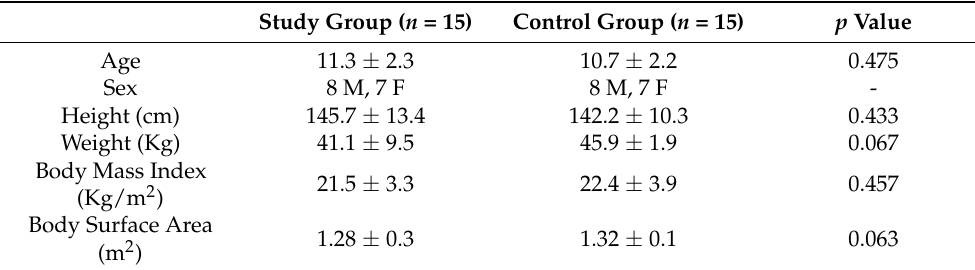
Table 1. Clinical and demographic characteristics in the study group and control